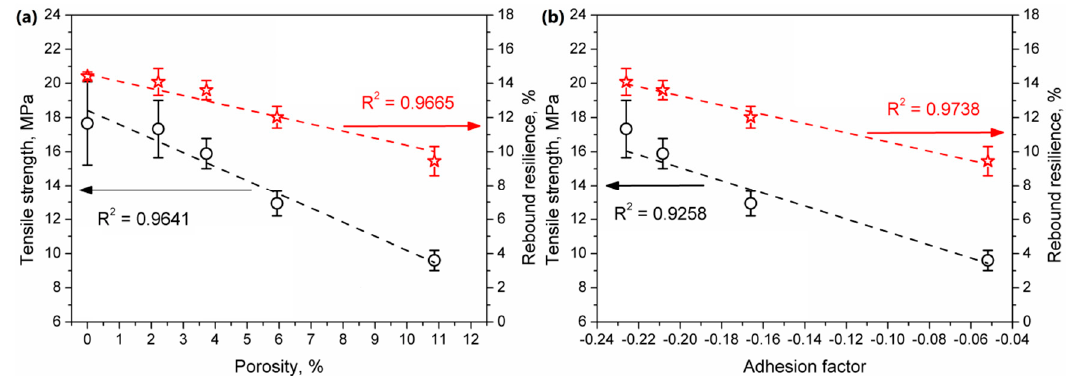
Figure 11. The impact of ( a ) porosity and ( b ) adhesion factor on the tensile strength and rebound resilience of the rotationally molded samples.